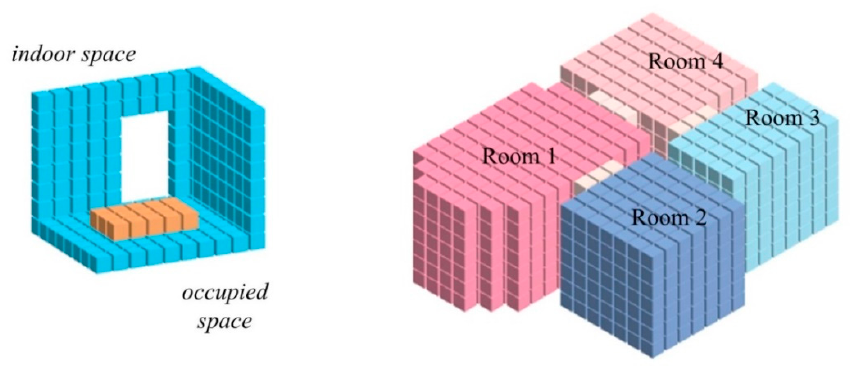
Figure 4. Occupied space and free space is labeled with room information after 3D room segmentation.